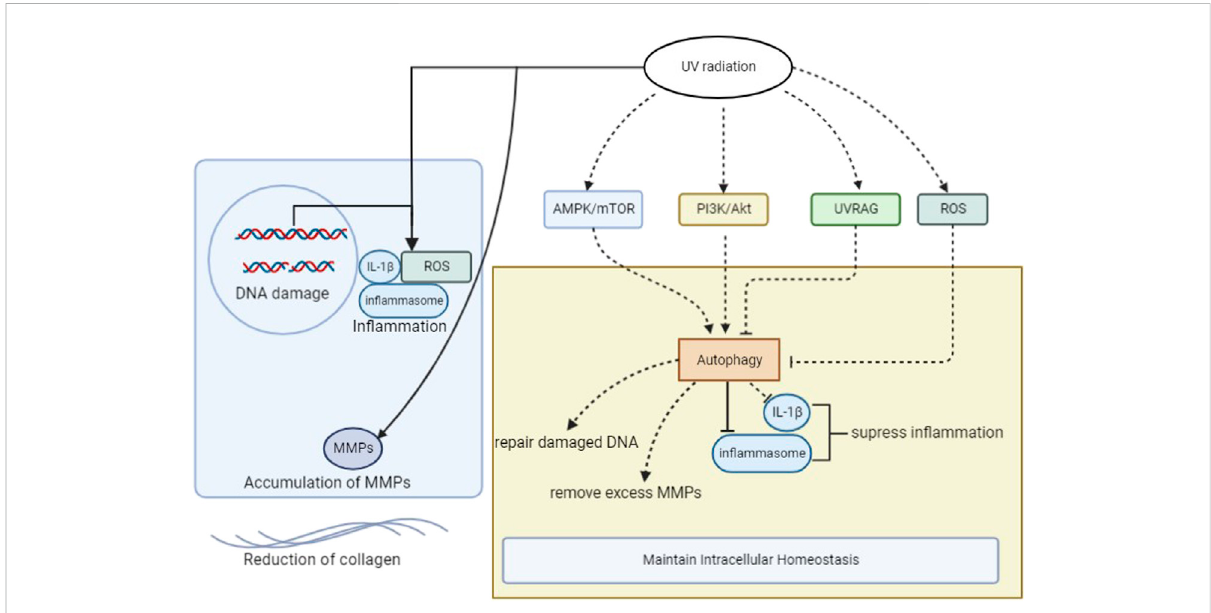
FIGURE 1 The mechanism of photoaging and the role of autophagy after UV radiation in photodamaged skin cells. ROS, reactive oxygen species; UV, ultraviolet; IL-1 β , Interlukin-1 β ; UVRAG, UV Radiation Resistance Associated Genes; MMPs, matrix metalloproteinases.